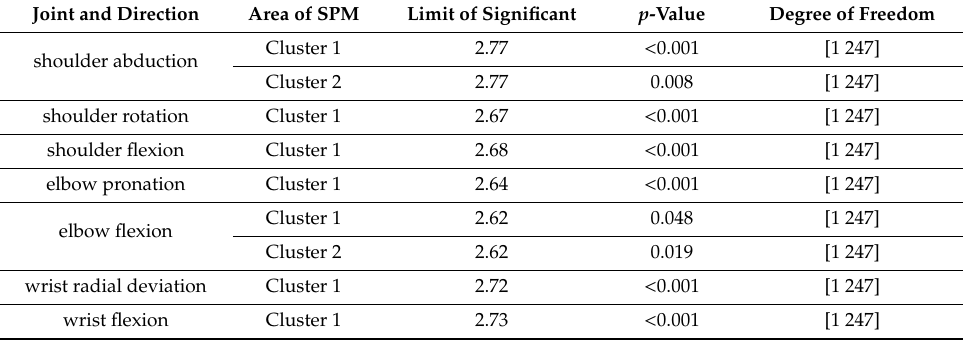
Figure 5. Movement profile of the two floor conditions for the right shoulder ( a ), elbow ( b ) and wrist ( c ) in the habitual vacuuming cycle (mean—solid line and standard deviation–area). The time dependent angles were time normalized to a full movement cycle. Blue indicates the carpet condition, yellow the polyvinyl chloride (PVC) condition. Positive values of the statistical parametric mapping (SPM) indicate greater angles for the PVC than for the carpet at the specific time point. Significant difference of clusters is reached when the z value of the SPM is outside the red dotted lines. Table 3. Results of the SPM applied to the two floor conditions. The SPM tests the difference between two conditions with respect to the smoothness. Therefore only statements about clusters can be made. The clusters mentioned in the table are labelled according to their occurrence from 0 to 100% in the movement cycle. The limits of significance are based on the waveforms of the individual joint directions. The p -value is only reported for significant clusters.